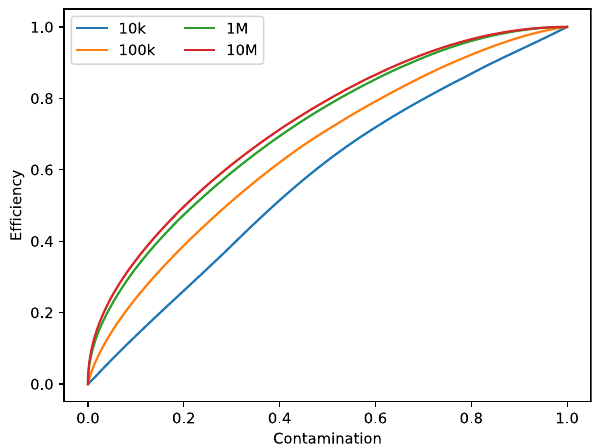
Fig. 9 ROC curve in the semi-leptonic channel, showing dependency onthetrainingunpolarizedOSPdatasetsize(10 4 ,10 5 ,10 6 ,10 7 events). Number of neurons is fixed to 60 and number of hidden layers to 4